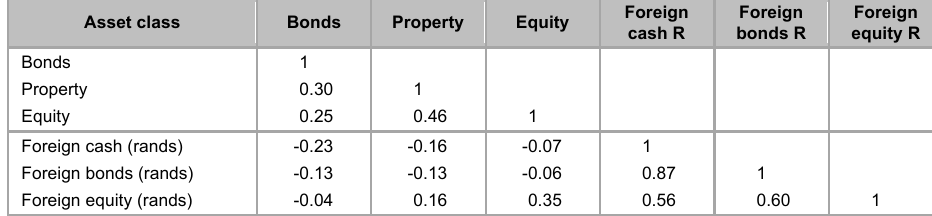
Correlation matrix between major asset classes (Jan 1971 to Dec